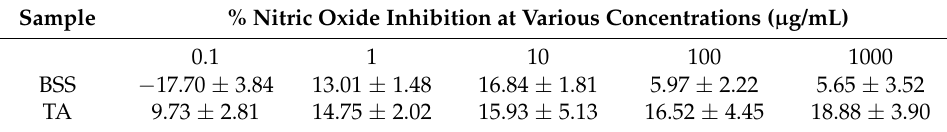
Table 1. Inhibitory activity of the sterol fraction (BSS) and triamcinolone acetonide (TA) of nitric oxide (NO) production in lipopolysaccharide (LPS)-stimulated RAW 264.7